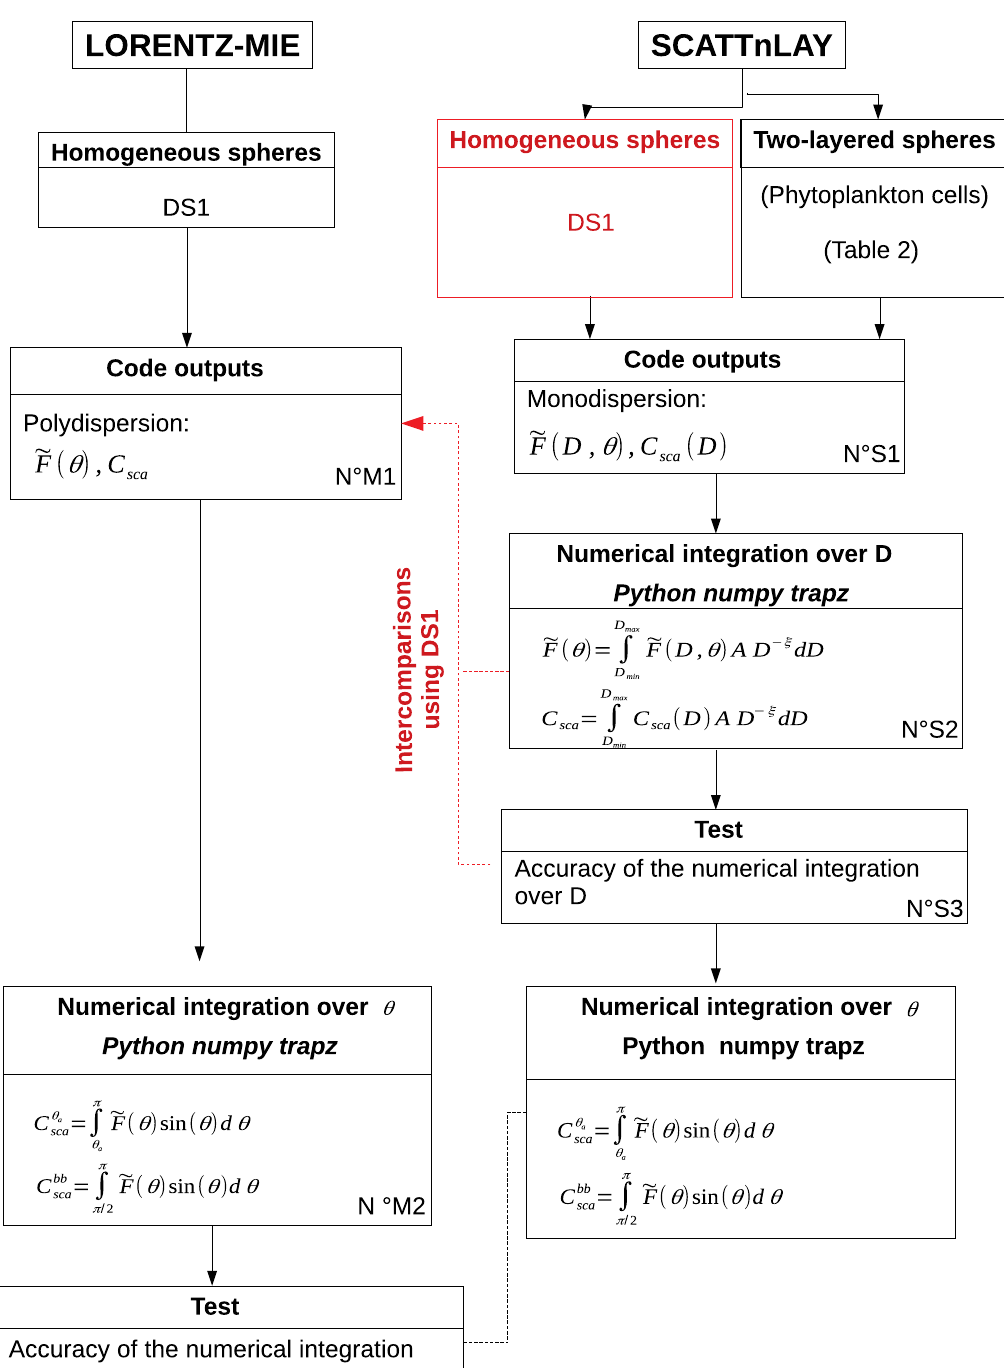
Figure 1. Flow chart of the integration procedure applied to the MIE and ScattnLay